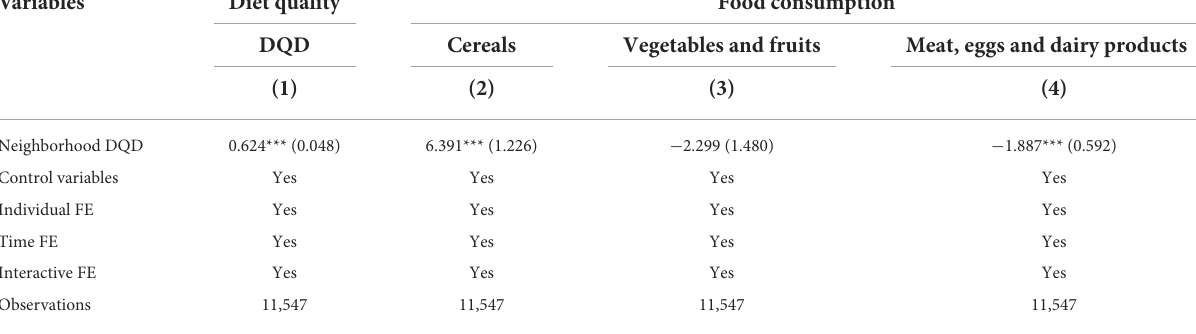
TABLE 5 Estimation of neighborhood effects on dietary behaviors of older adults (fixed effects estimators, DQD indicator).